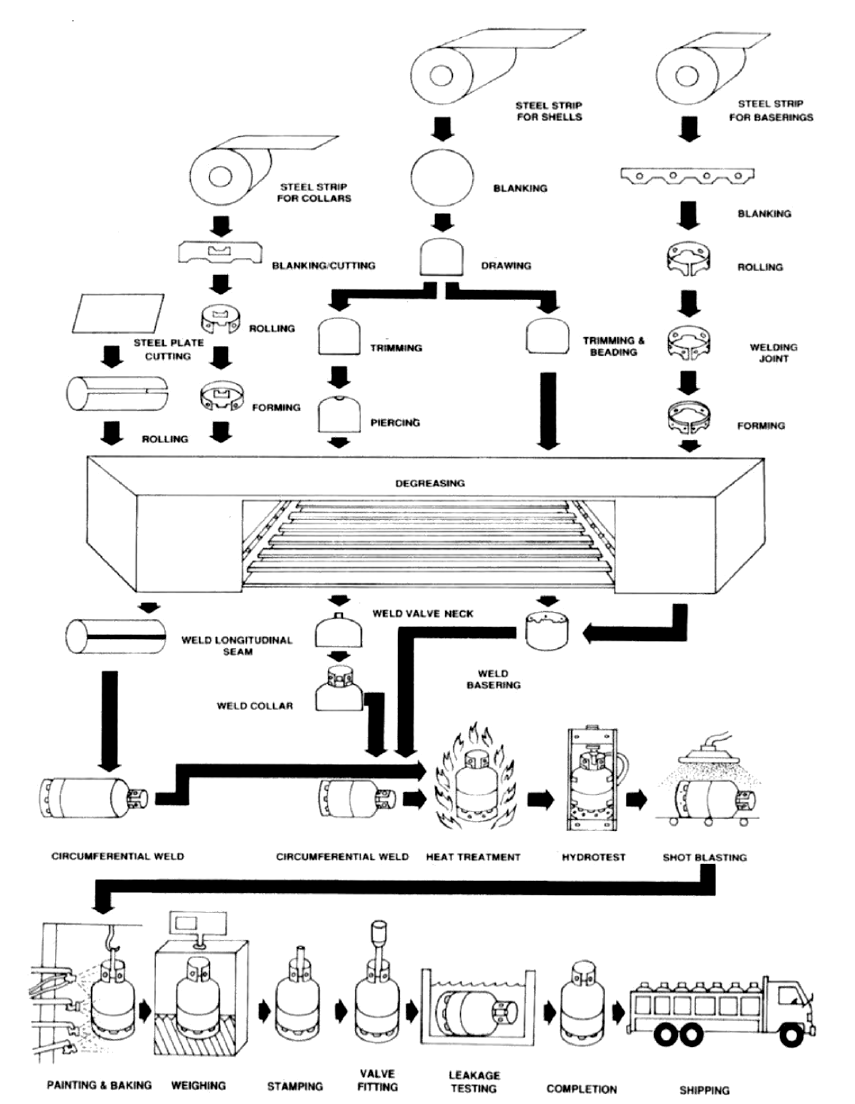
Figure 1: The process of manufacturing of LPG cylinders (Bhadur and Marg,